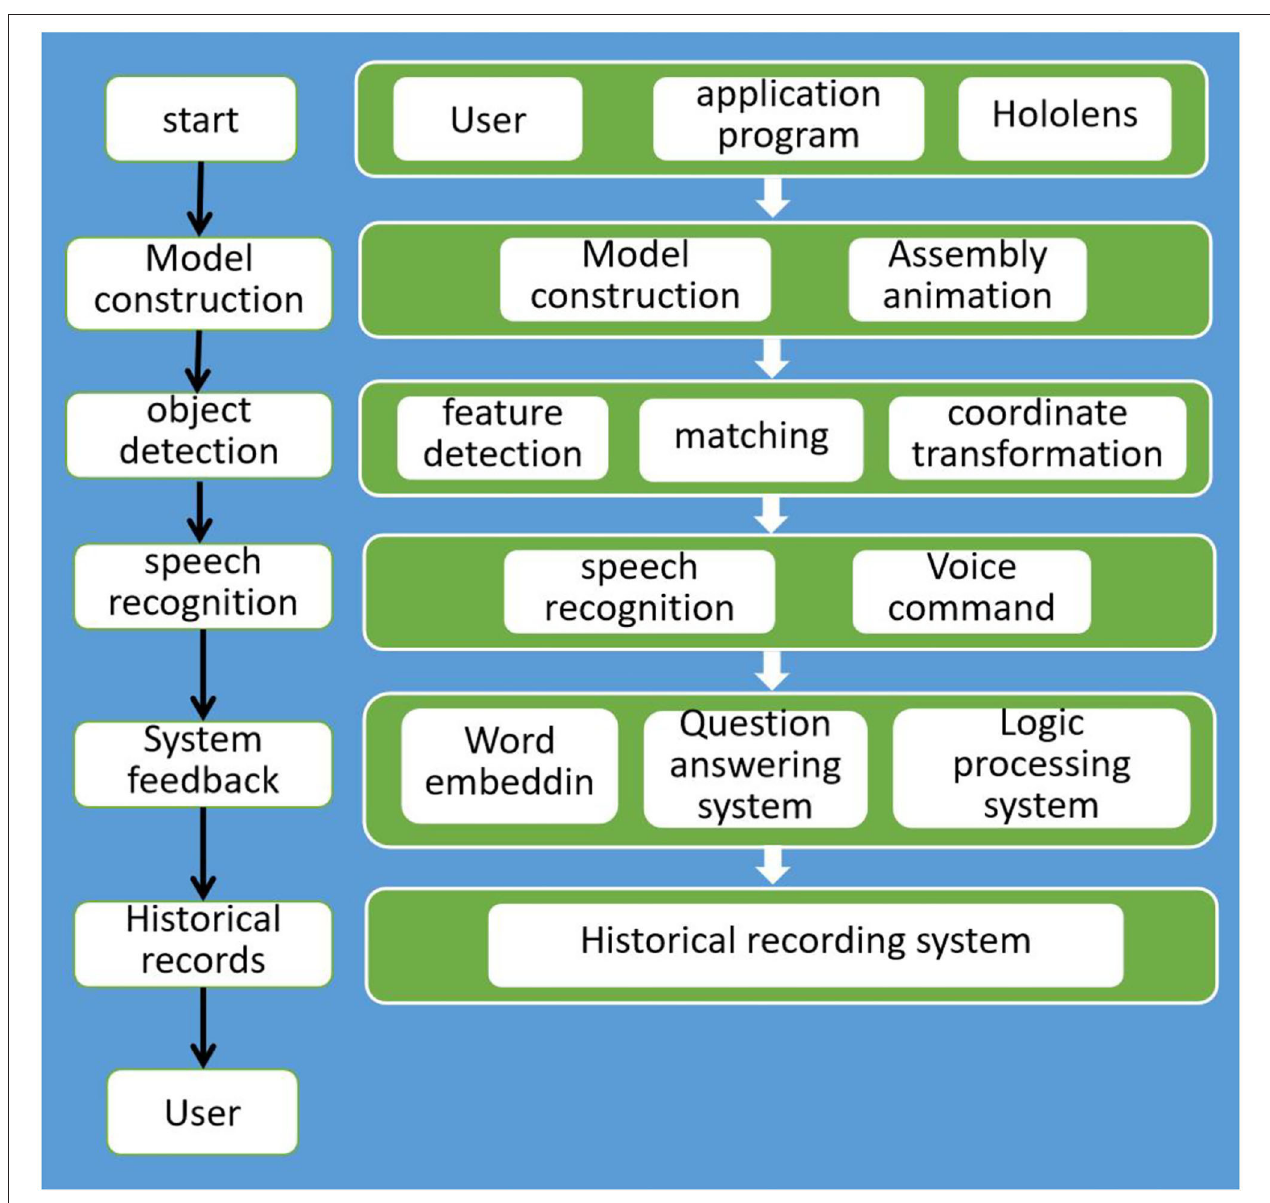
FIGURE 5 | Overview of the system